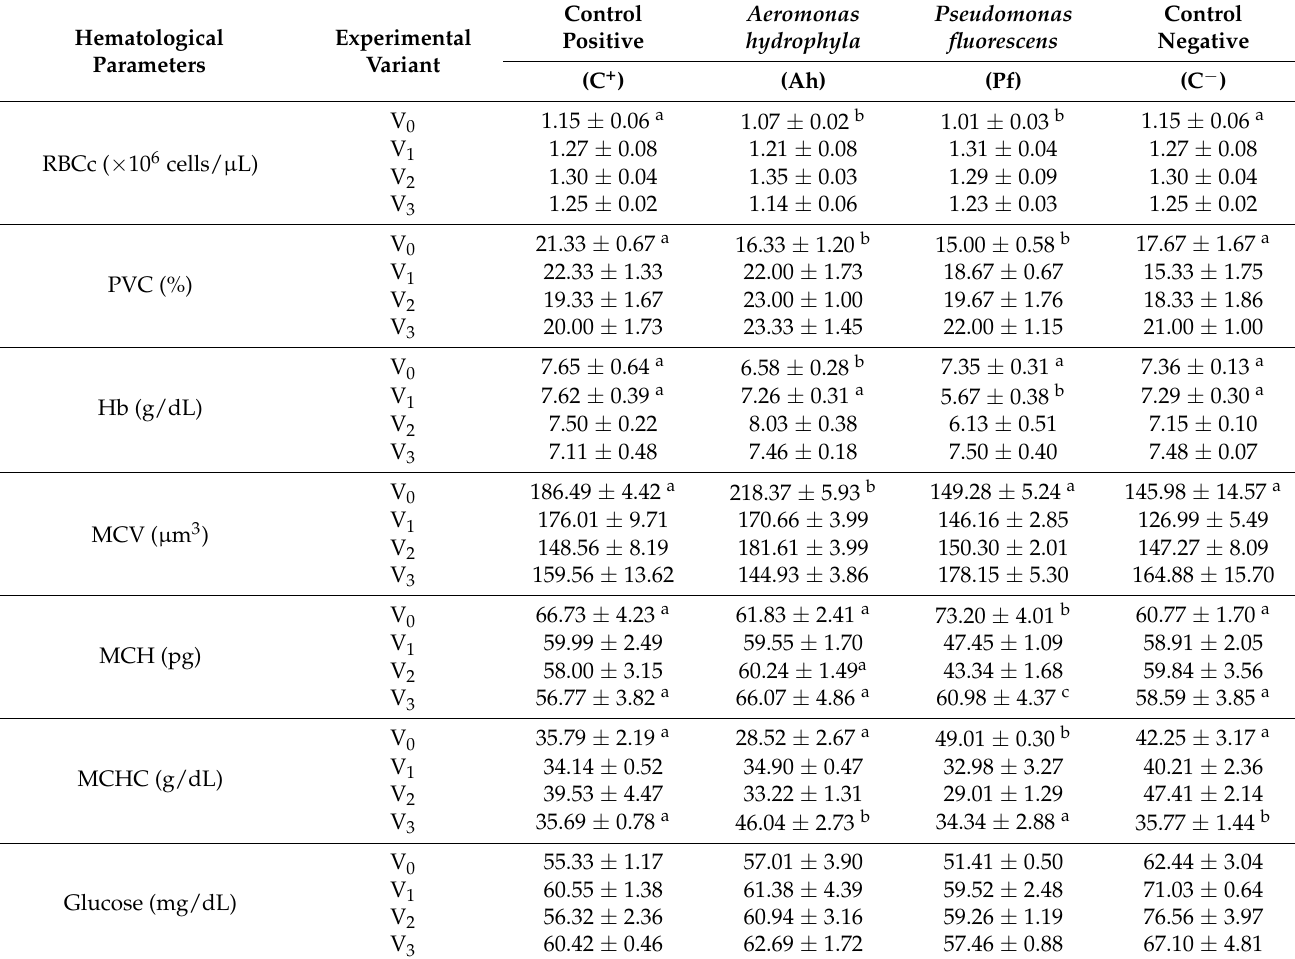
Table 4. Hematological parameters after challenge test with Aeromonas hydrophila and Pseudomonas fluorescens